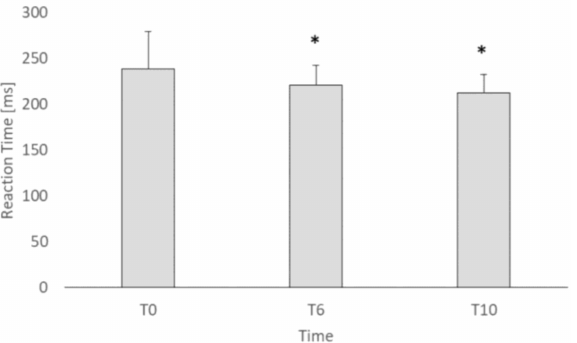
Figure 1. Subjects’ reaction time (ms) pre (T 0 ) and post (T 6 ) dance intervention and after summer season (T 10 ). * p < 0.05 vs T 0